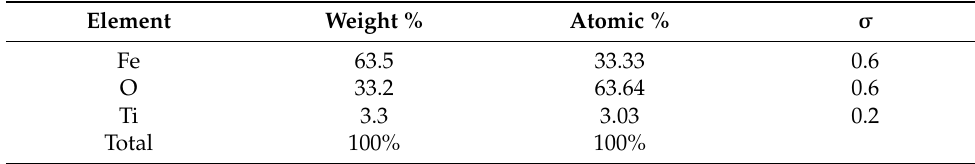
Table 1. Elemental composition details as obtained from